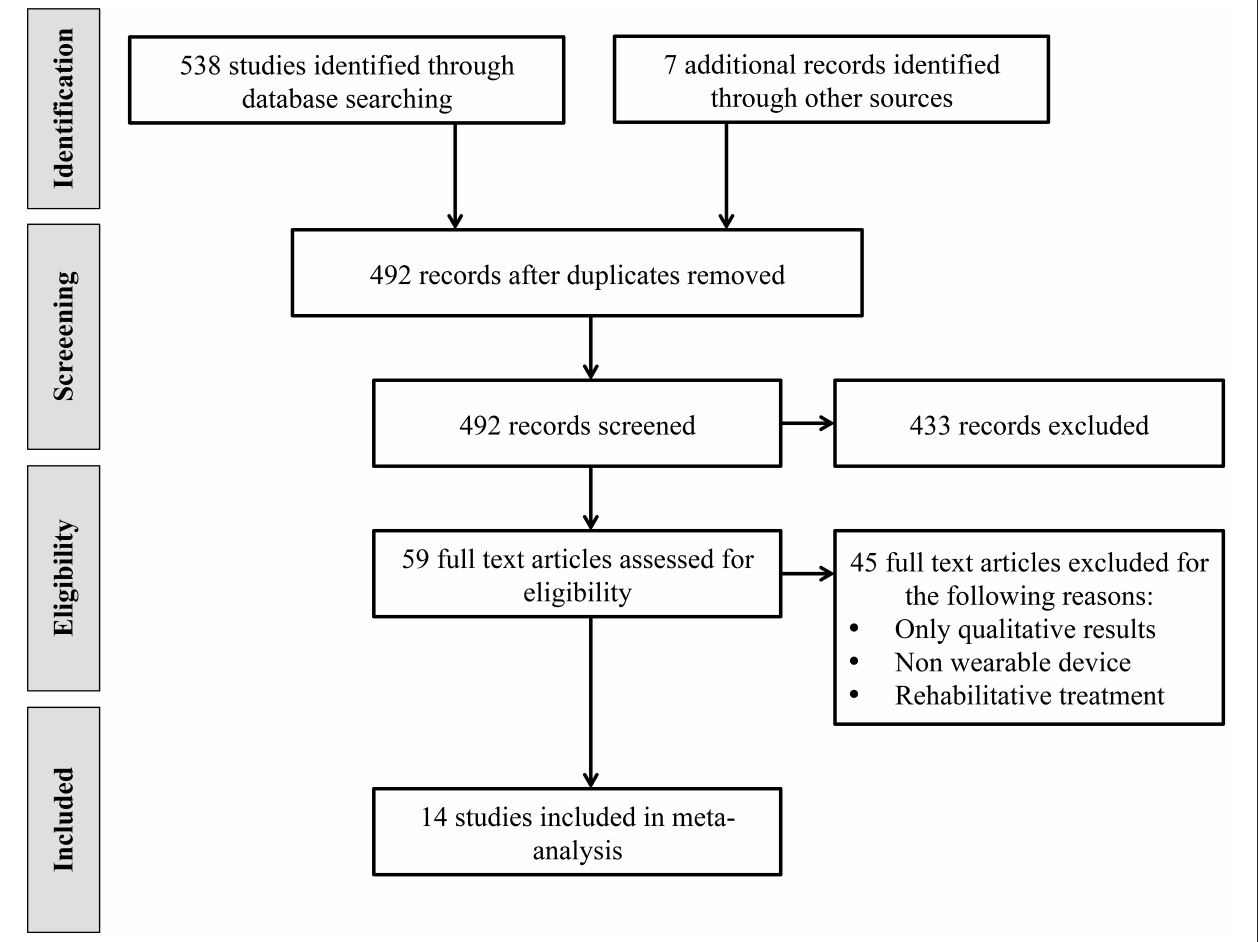
FIGURE 1 | PRISMA flowchart of the literature search